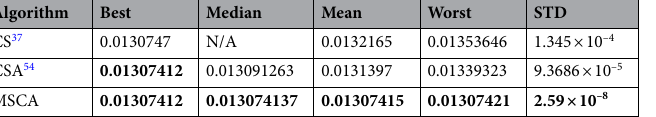
Table 12. Statistical result for vertical deflection of an I-beam problem. Significant values are in